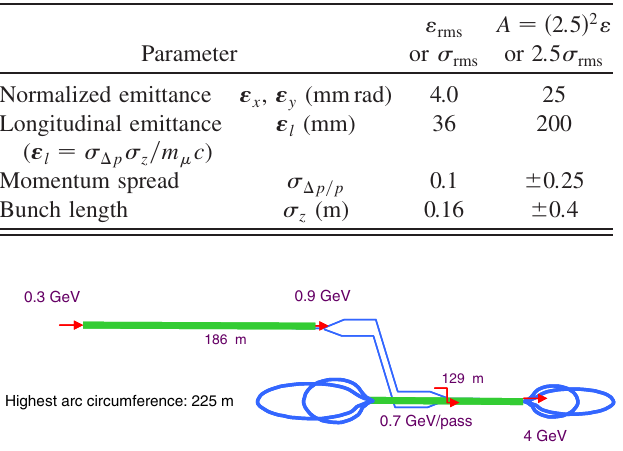
FIG. 6. (Color) Layout of the accelerator complex. For compact- ness both components (the preaccelerator and the dogbone RLA) are stacked vertically; (cid:2) (cid:1) beam transfer between the accelerator components is facilitated by the vertical double chicane (see